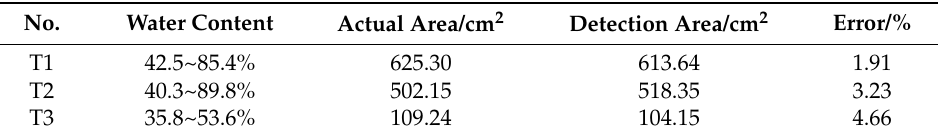
Table 1. Errors of detection results.